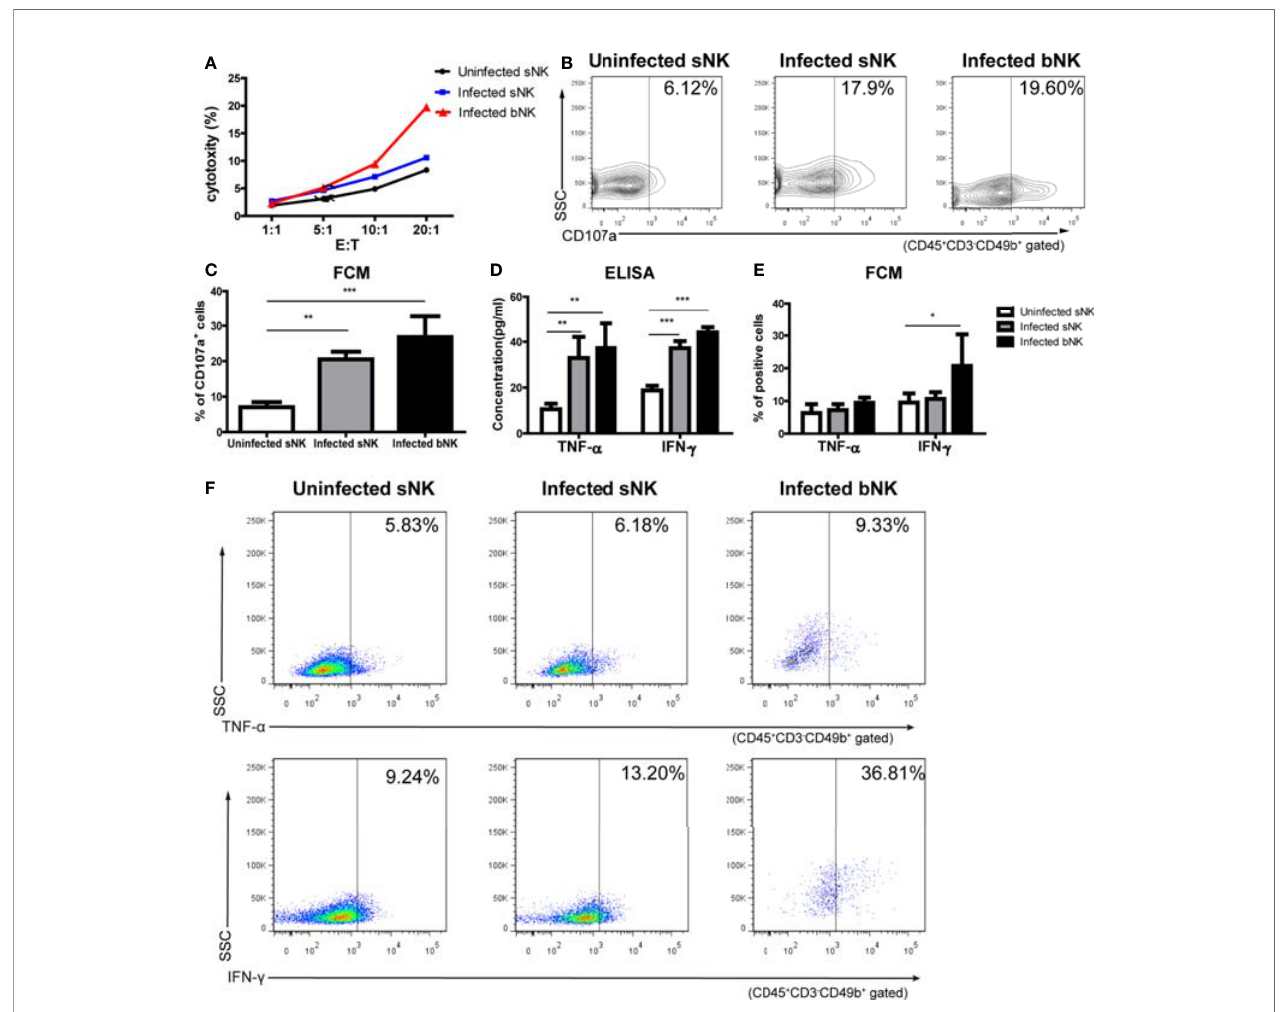
FIGURE 5 | The cytotoxicity and secretory ability of NK cells elevated after A. cantonensis infection. (A) NK cell-mediated cytotoxicity against YAC-1 cells. Puri fi ed sNK and bNK (as effector cells) were incubated with YAC-1 cells (as target cells) at various effector cell/target cell ratios (E:T = 1:1, 5:1, 10:1, 20:1). NK cell-mediated cytotoxicity was detected by LDH release assay. (B, C) The expression of CD107a on NK cells. Splenic lymphocytes and brain mononuclear cells were isolated and detected by FCM. Gating strategy for the mouse CD45 + CD3 - CD49b + NK cell population was shown in Figure S2 . (D) The concentrations of TNF- a and IFN- g in the culture supernatants of NK cells. Puri fi ed sNK and bNK were stimulated with IL-12 and the concentrations of TNF- a and IFN- g in the culture supernatants were detected using ELISA. (E, F) The expression of intracellular cytokine TNF- a and IFN- g in NK cells. Splenic lymphocytes and brain mononuclear cells were isolated and stimulated with Leukocyte Activation Cocktail. The percentage of TNF- a + cells and IFN- g + cells in CD45 + CD3 - CD49b + NK cells was detected by FCM. Data are expressed as the means ± SD. Data shown represent analysis from two independent experiments with four mice per group. Multiple comparisons were performed by one-way ANOVA. * P < 0.05; ** P < 0.01; *** P < 0.001. sNK, NK cells in spleen; bNK, NK cells in